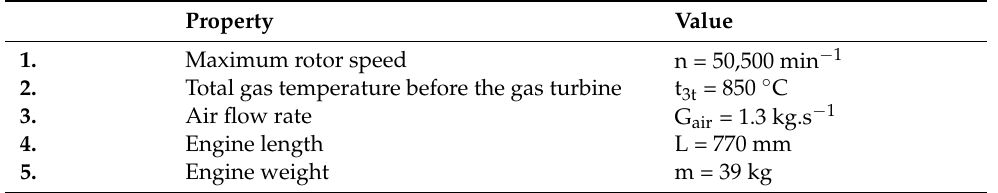
Figure 2. Cut way of small jet motor SJE-20 . Table 1. Basic technical data SJE-20.